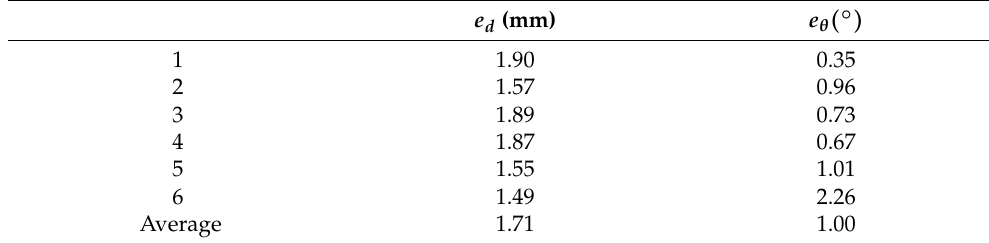
Table 5. Results of the tumor phantom biopsy experiments.